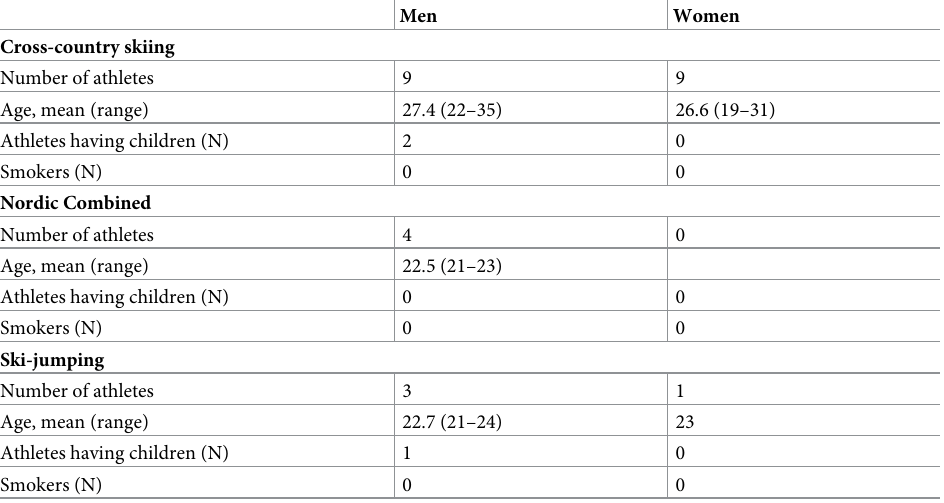
Table 1. Characteristics of 26